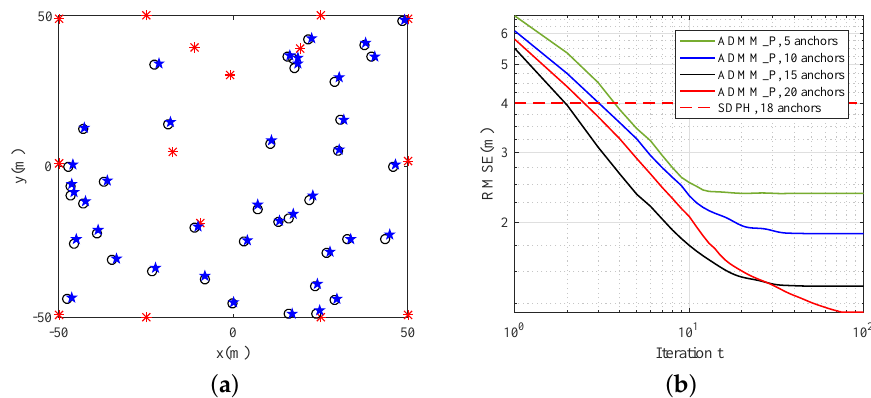
Figure 8. Estimation results of sensor network with 10 fixed anchors, five randomly distributed anchors, and 40 randomly distributed sensors. ( a ) Estimation locations. Red asterisks *: anchor locations; black circles ◦ : true sensor locations; blue stars (cid:63) : estimation results; ( b ) RMSE